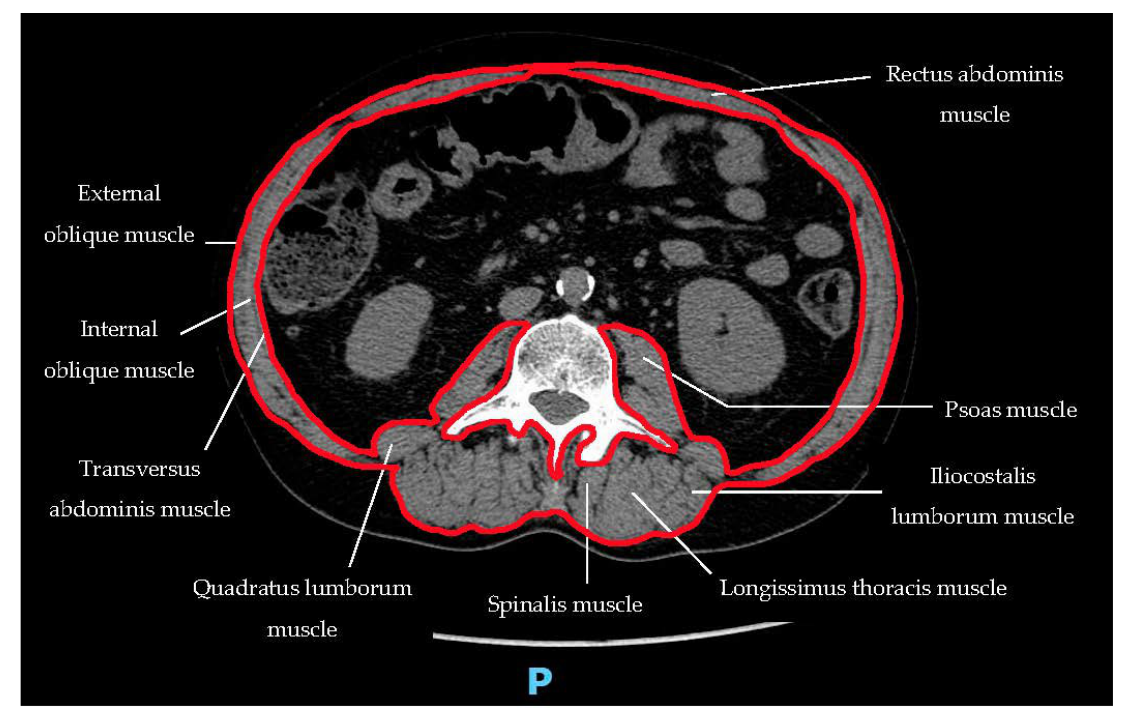
Figure 2. Example of delineation of the skeletal muscle area on a CT scan at the level of the third lumbar vertebra. Table 2. Common cut-offs for sarcopenia definition based on CT-scan at the level of the third lumbar vertebra.